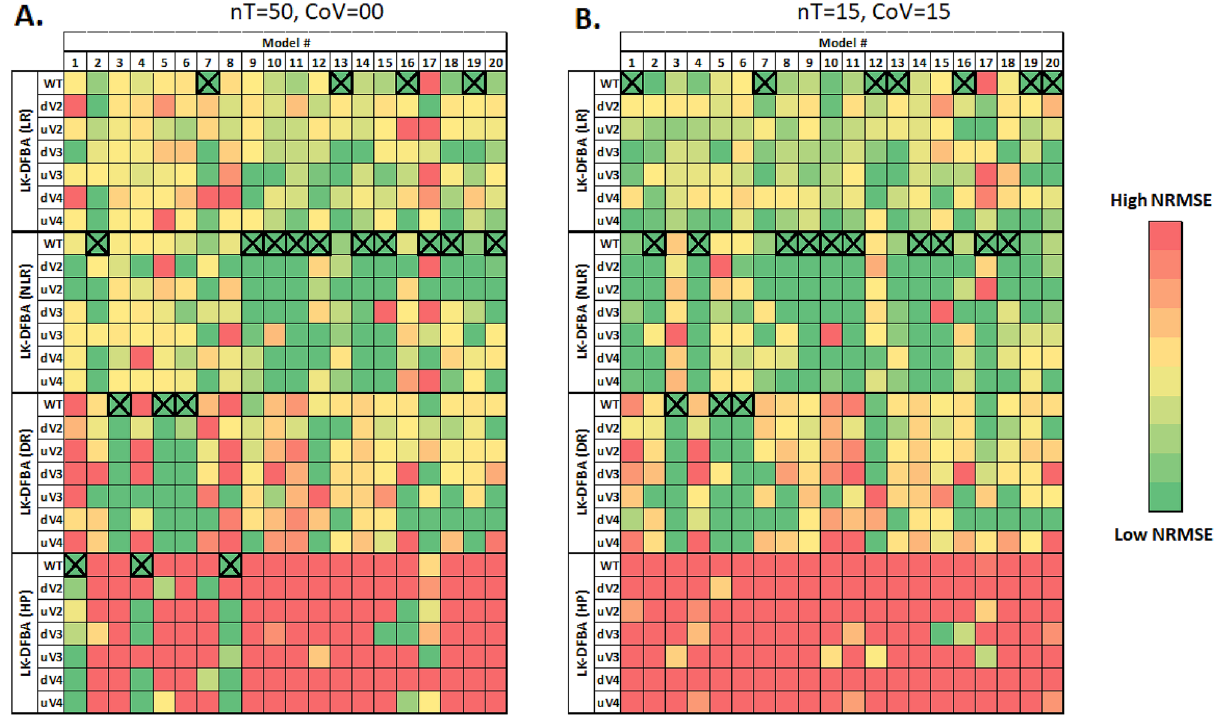
Figure 2. NRMSE heatmap of LK-DFBA approaches on different synthetic models. Each constraint approach was used to fit parameters to wild-type (WT) data and then used to simulate the WT system and in silico genetic perturbations with fluxes v 2 , v 3 , or v 4 down- or up-regulated. The best constraint approach for each WT model is indicated with an X. Dark green boxes represent the lowest NRMSE within each genetic perturbation for each synthetic model, while dark red boxes represent the highest NRMSE (meaning that the dynamic range of the color scale varies for each perturbation for each synthetic model to better convey the relative performance of different methods). Panel A shows results for noiseless data with a sampling frequency of 50 time points. Panel B shows results for noisy datasets with a sampling frequency of 15 time points and with noise added at a CoV of 0.15. The average NRMSE of 10 noisy datasets is shown in the heatmap. The same NRMSE heatmaps with explicitly annotated error values can be found in Figs. S1 and